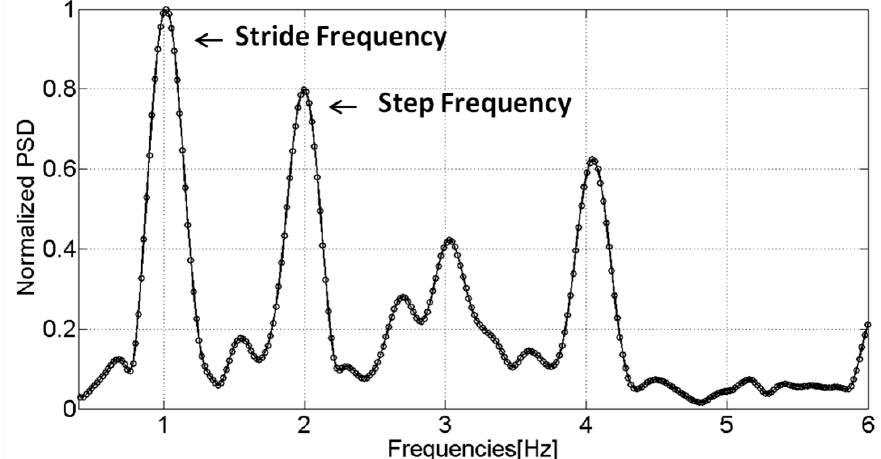
Figure 5. Normalized PSD for the accelerometer sensed by the user’s swinging hand. Here, the strongest frequency is coupled with stride